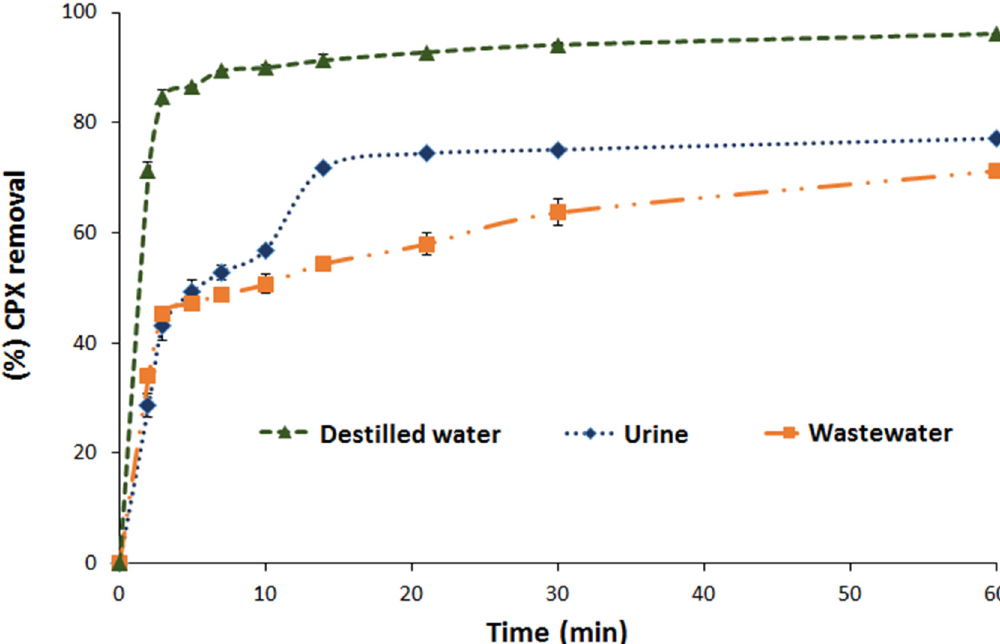
Figure 8. Adsorption of CPX in aqueous solution, in synthetic matrices of waste water and urine, using F Zn (conditions: matrices doped with 25 mg L − 1 of CPX, adsorbent dose 1.6 g L − 1 ).